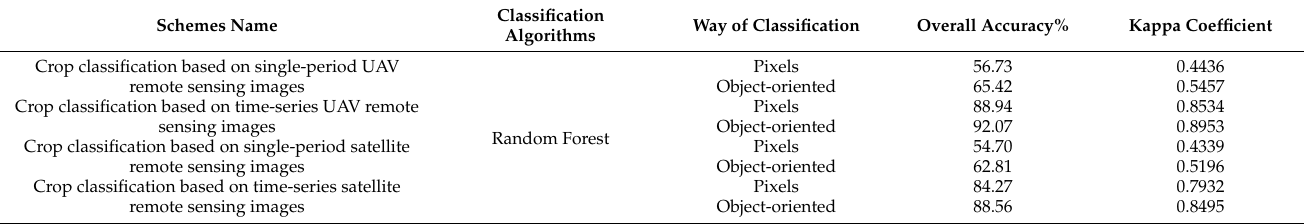
Table 4. Results of crop classification accuracy of remote sensing images with different time